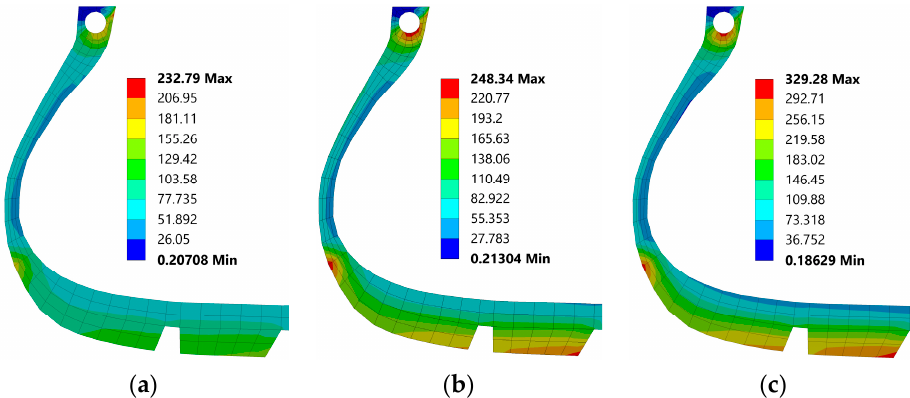
Figure 18. Distribution of heat flux in rubber with different velocities (unit: W/m 3 ): ( a ) 40 km/h; ( b ) 80 km/h; ( c ) 120 km/h.